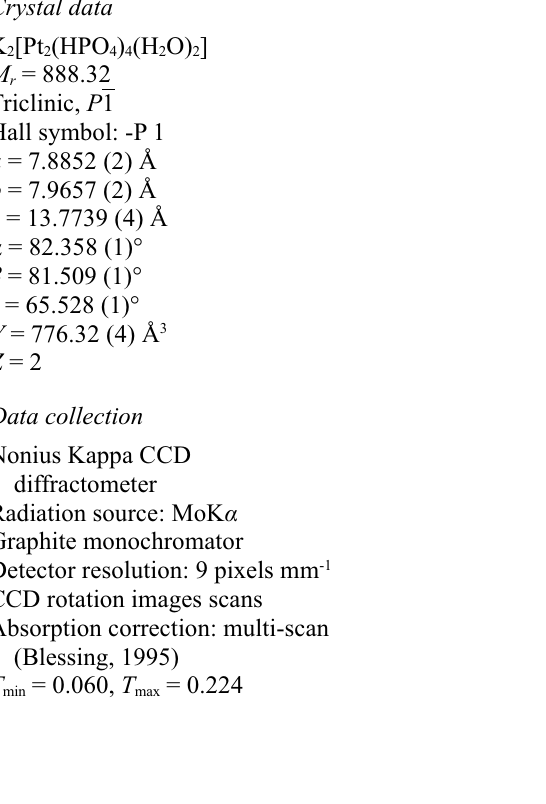
[(Pt )(HPO 2 2 ) (H O) ] 4 4 2 2